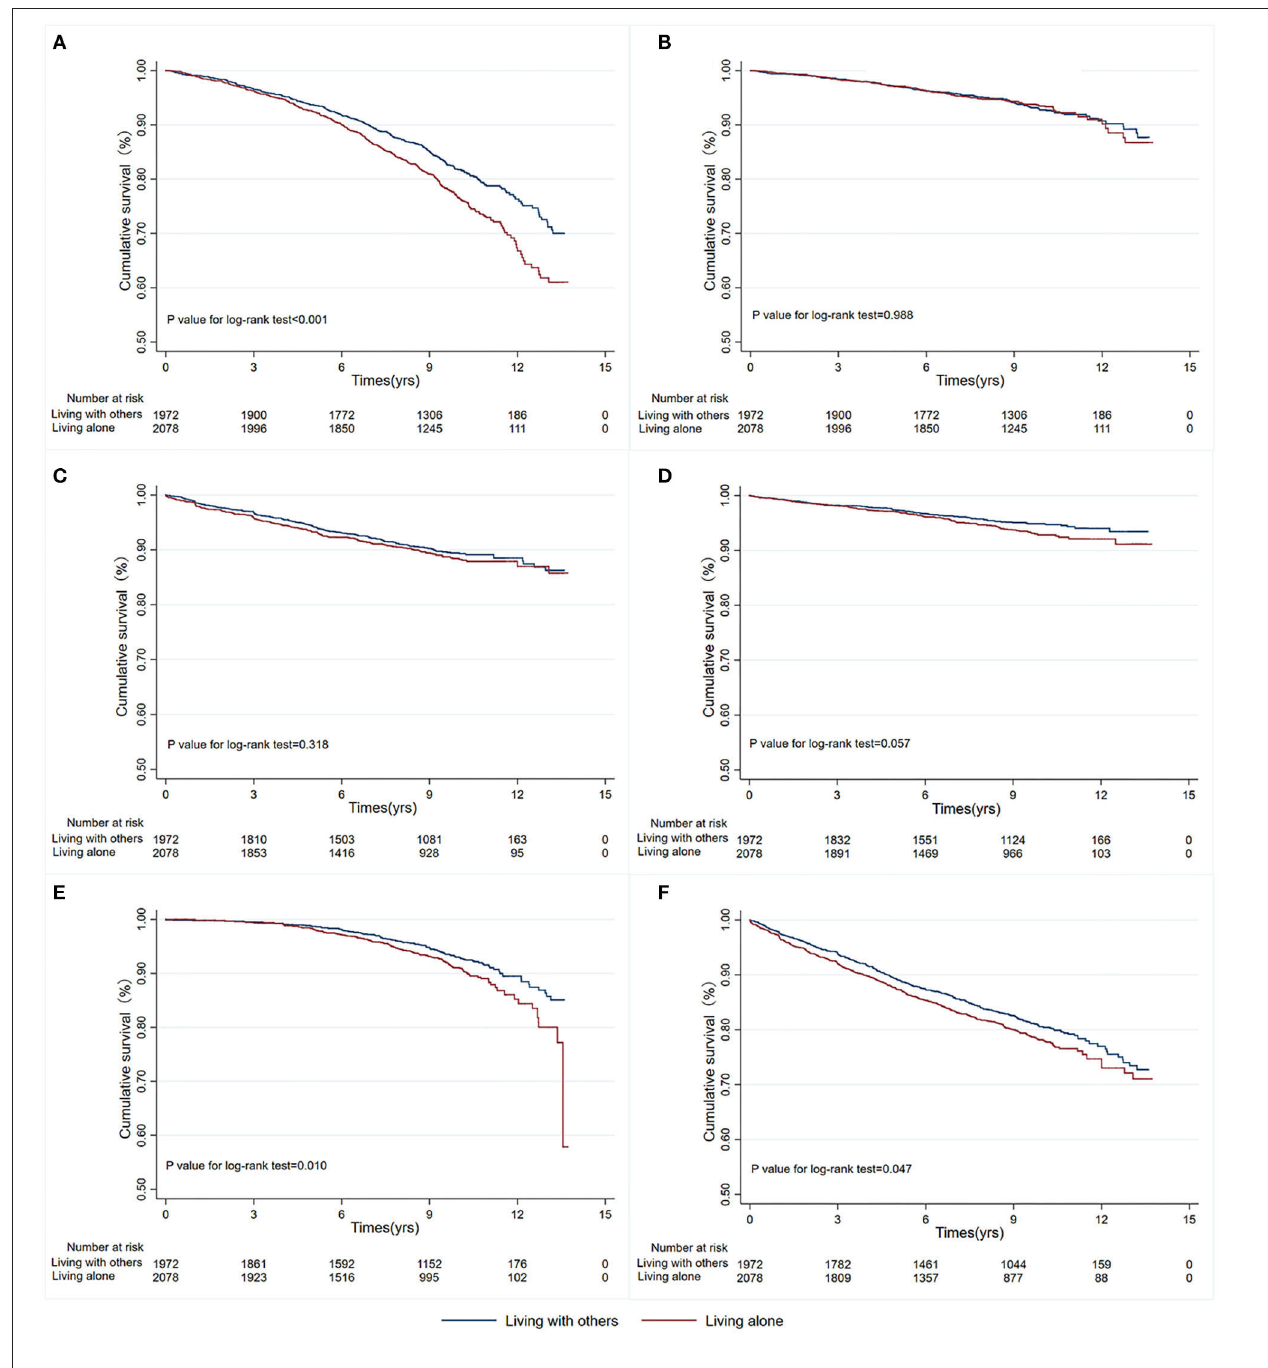
FIGURE 2 | Kaplan-Meier survival curves for primary and secondary outcomes in propensity score-matched patients with different living status. (A) All-cause mortality; (B) Cardiovascular mortality; (C) Non-fatal MI; (D) Non-fatal stroke; (E) CHF; (F) CHD. MI, myocardial infarction; CHF, congestive heart failure; CHD, coronary artery